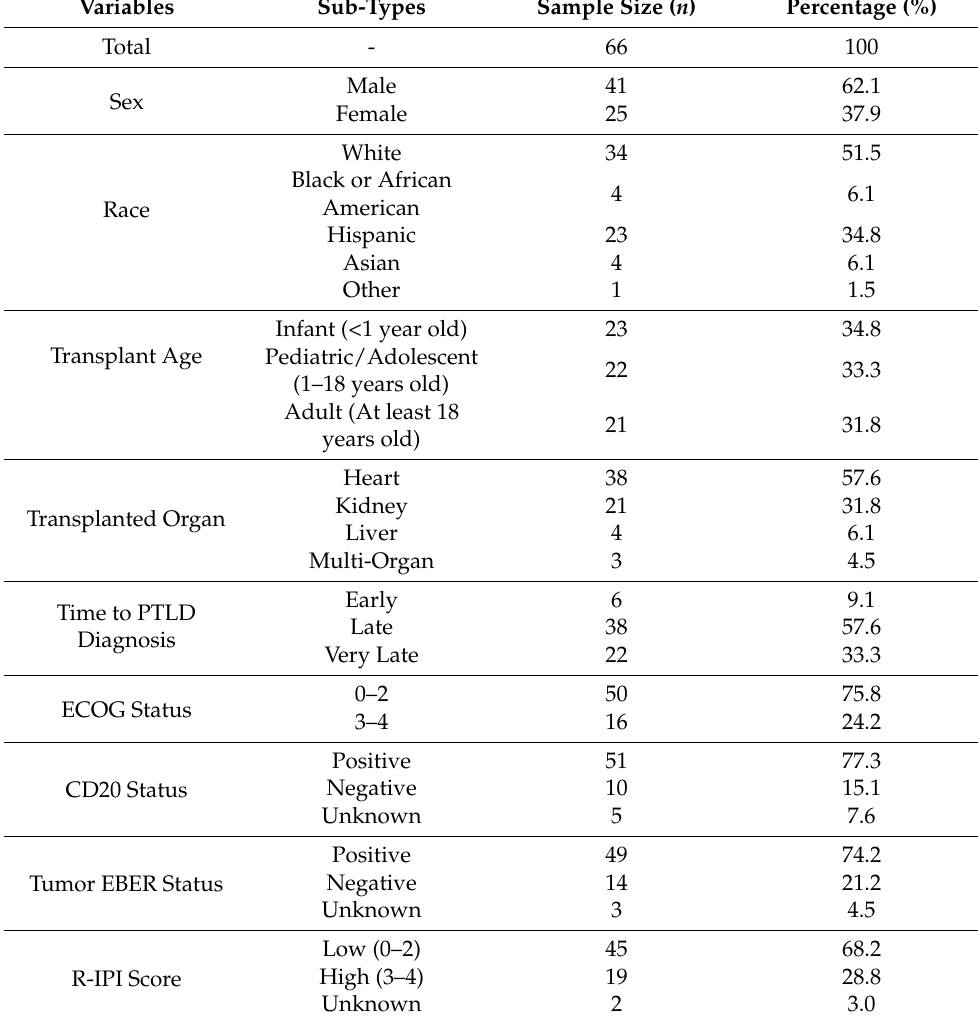
Table 1. Clinical characteristics of post-transplant lymphoproliferative disorders (PTLD)